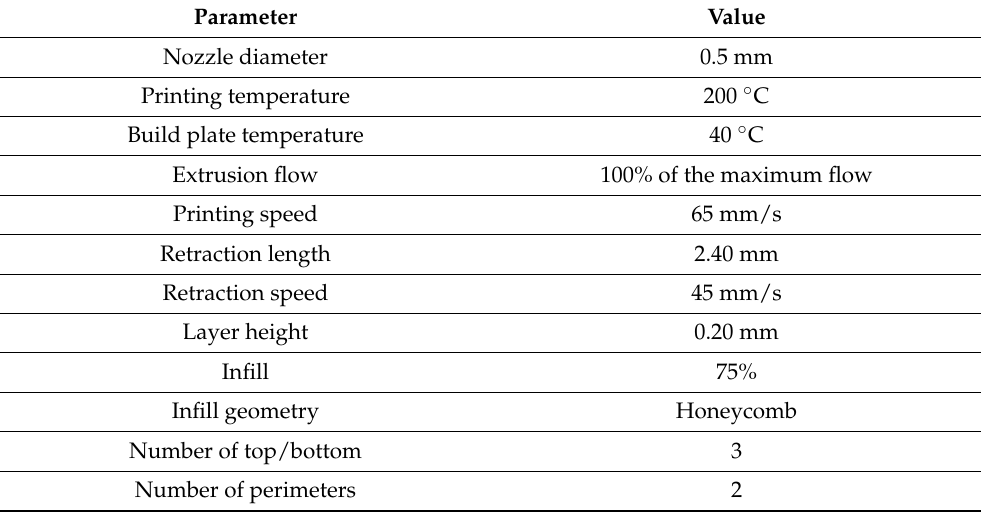
Figure 1. Digital models with dimensional details of ( a ) the trapdoor tool and ( b ) the template used for programming the temporary shape, together with photographs of the actual printed objects. Table 2. Operating parameters set for the PLA